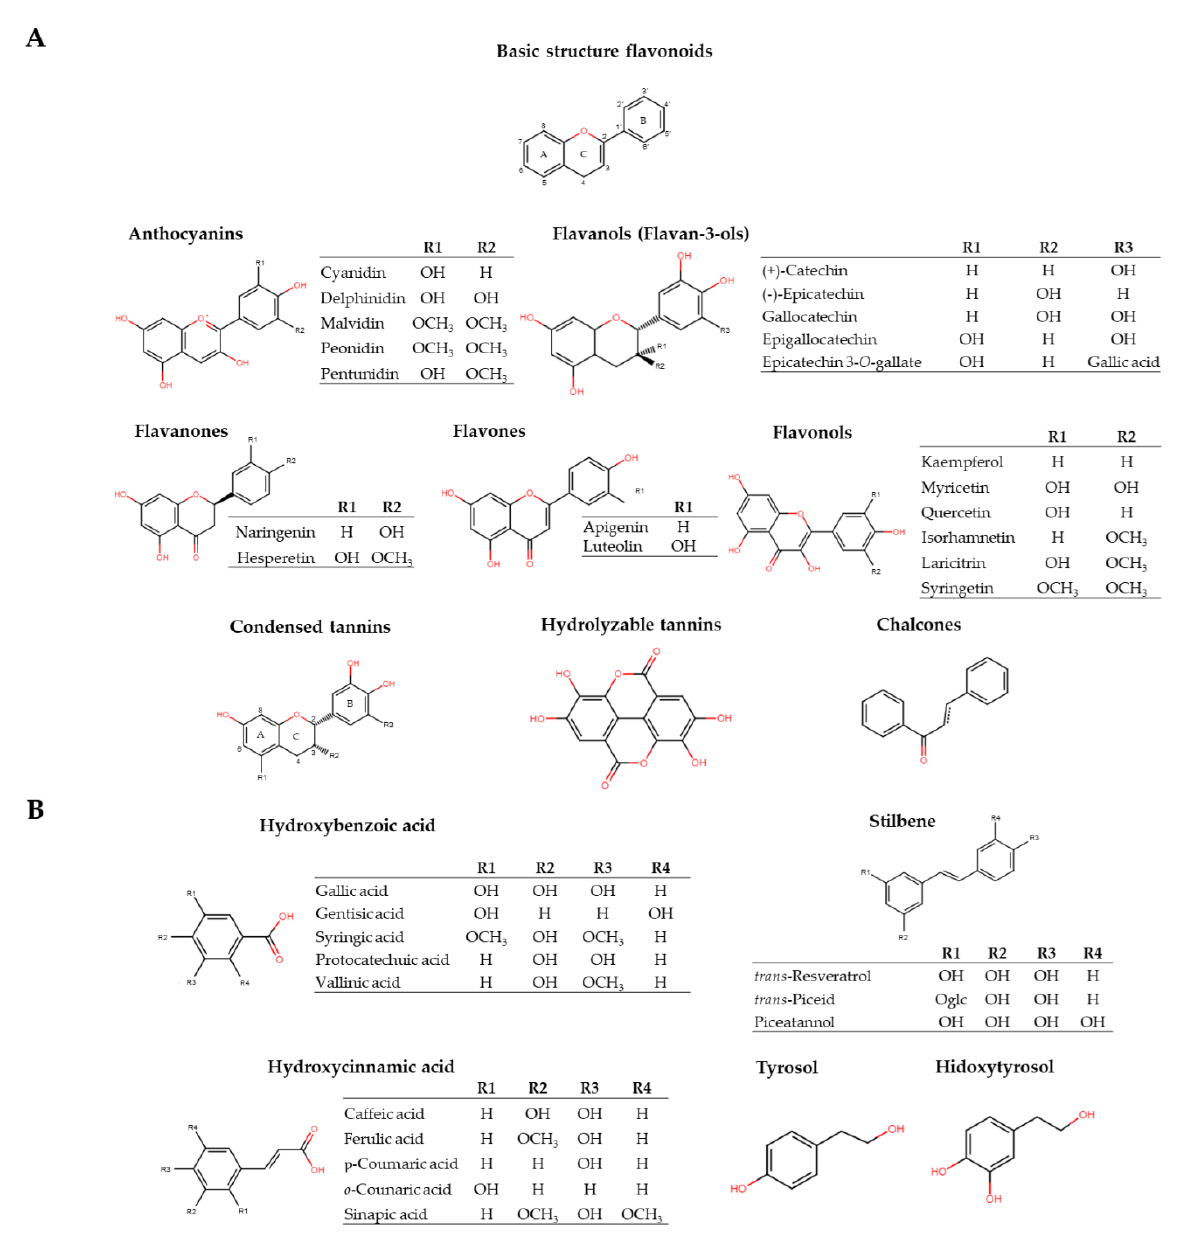
Figure 1. ( a ) Structure of the flavonoid compounds in wine; ( b ) Structure of the non-flavonoid compounds in wine. (Own elaboration).